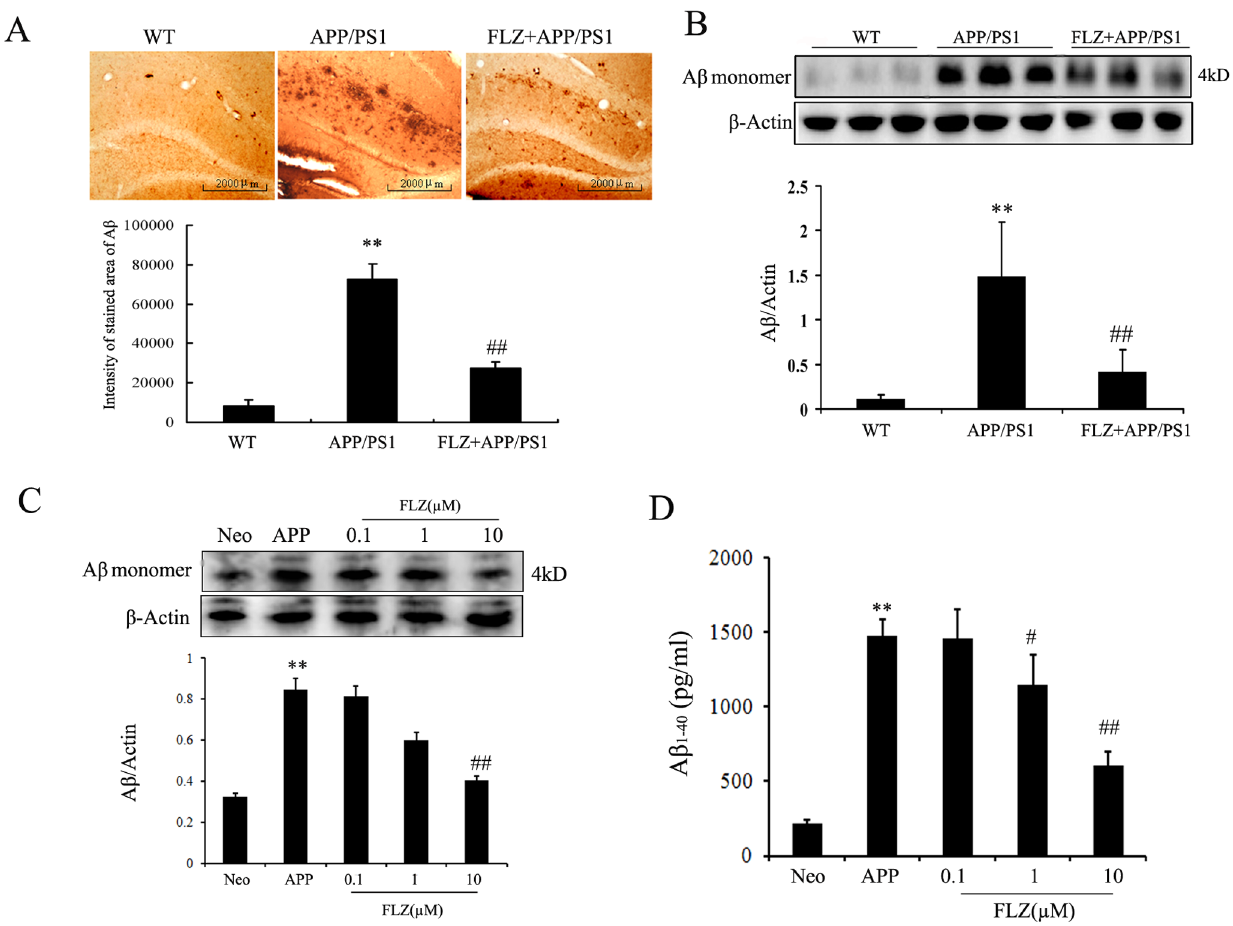
Figure 4. FLZ inhibited A b production in APP/PS1 mice and SH-SY5Y (APPwt/swe) cells. APP/PS1 double transgenic mice were orally treated with FLZ 150 mg/kg for 20 weeks. SH-SY5Y (APPwt/swe) cells were grown in ‘‘stimulating medium’’ containing 50% DMEM, 50% Opti-MEM, 0.5% FBS, 200 m g/ml G418 and 10 mM butyric acid sodium salt for 12 h to induce the transgene expression. FLZ (0.1, 1 and 10 m M) were incubated with cells for 24 h. (A) Immunohistochemistry of A b deposits in hippocampus. Representative sections of hippocampus from 5 mice were shown. Scale bar: 500 m m. (B) Western blot assay of A b expression in hippocampus. A representative immunoblot from 4 mice was shown. Results were expressed as mean 6 SD. ** P , 0.01 vs . WT mice; # P , 0.05, ## P , 0.01 vs . APP/PS1 mice. (C) Western blot assay and (D) ELISA assay of A b 1–40 in SH-SY5Y (APPwt/swe) cells. The results were obtained from 4–6 independent experiments. Results were expressed as mean 6 SD. ** P , 0.01 vs . Neo SH-SY5Y cells, # P , 0.05, ## P , 0.01 vs . solvent-treated SH-SY5Y (APPwt/swe)